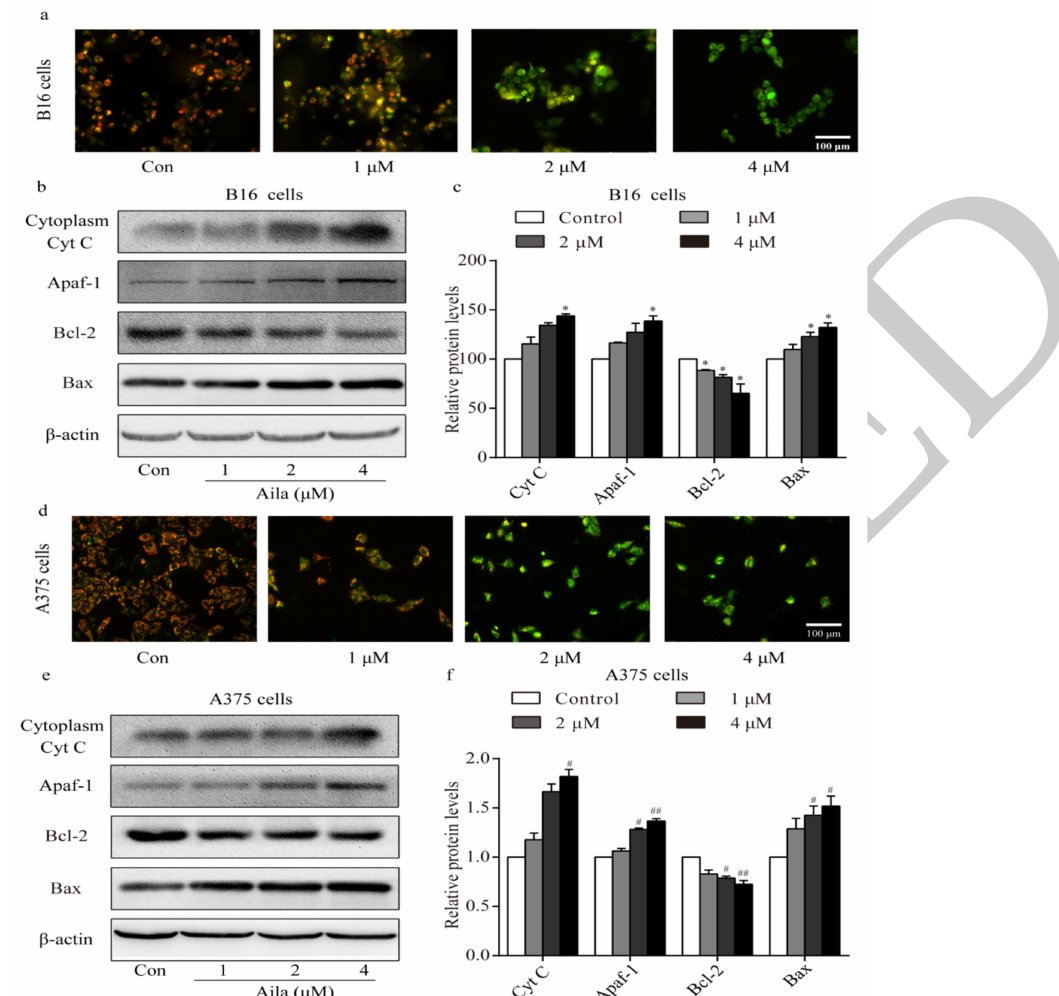
Figure 7. Ailanthone induces cell apoptosis in melanoma cells via the mitochondria-mediated apoptotic signaling pathway. ( a ) Changes in mitochondrial membrane permeabilization in ailanthone-treated B16 cells was observed by fluorescence microscopy. ( b ) The expression levels of cytoplasmic cytochrome C, Apaf-1, Bcl-2, and Bax in ailanthone-treated B16 cells were examined by Western blotting. ( c ) Quantitative analysis of the levels of cytoplasmic cytochrome C, Apaf-1, Bcl-2, and